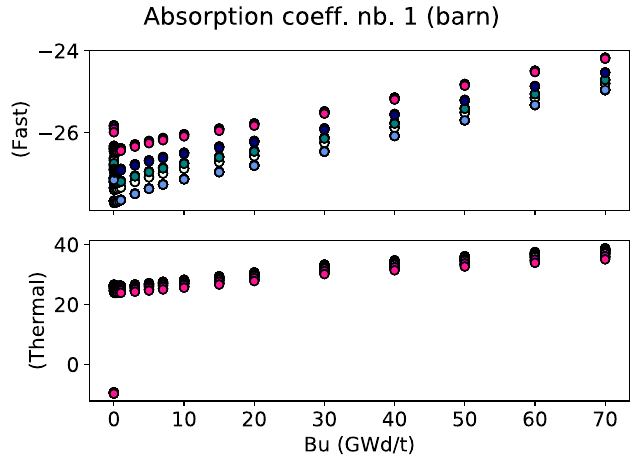
Fig. 6. Scatter plot of coefficient 1 along the burnup axis (UGd dataset).